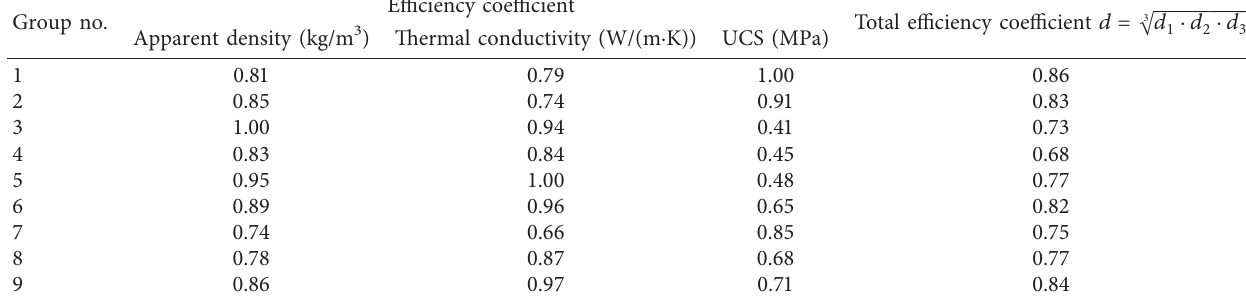
Table 5: Analysis of the efficacy coefficient